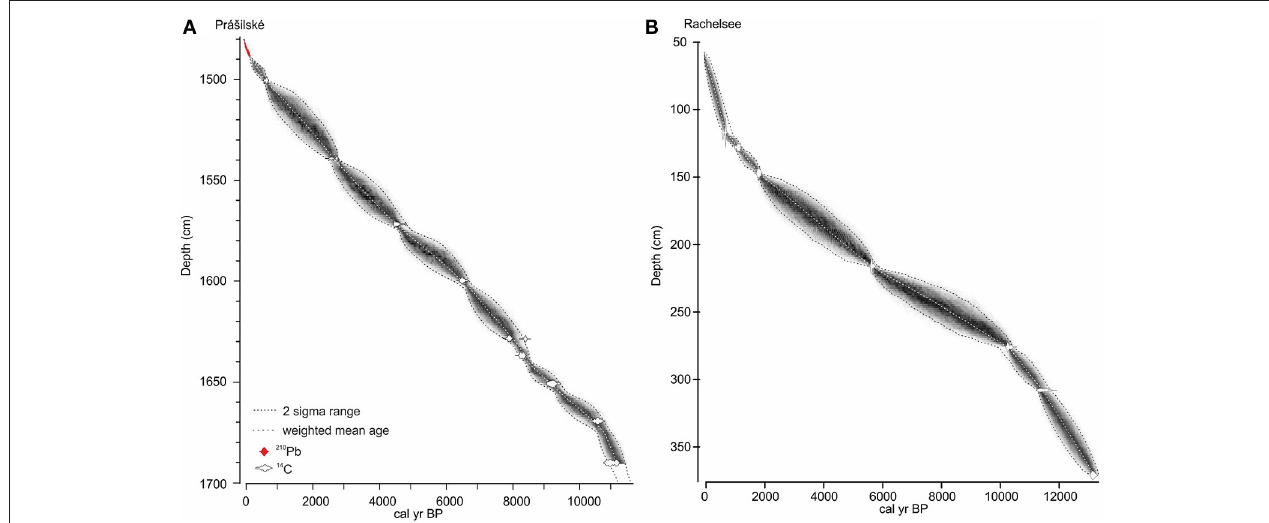
FIGURE 3 | Age-depth models for (A) Prášilské jezero, and (B) Rachelsee. Models were constructed using BACON. The weighted mean modeled ages against depth were smoothed using a 21-point moving average.